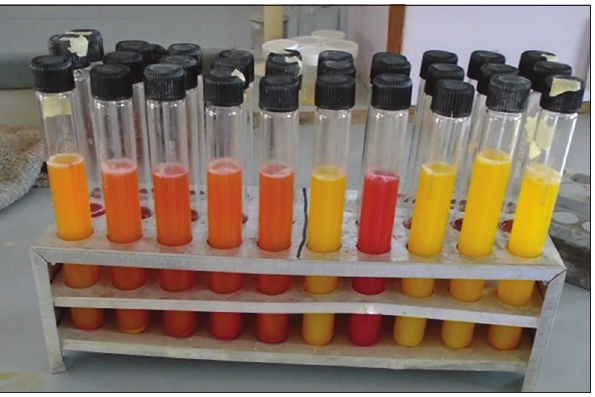
Table-1: Mean MPN index from sampled water in wells and boreholes from peri-urban areas of Makurdi (October 2015-September 2016). Location